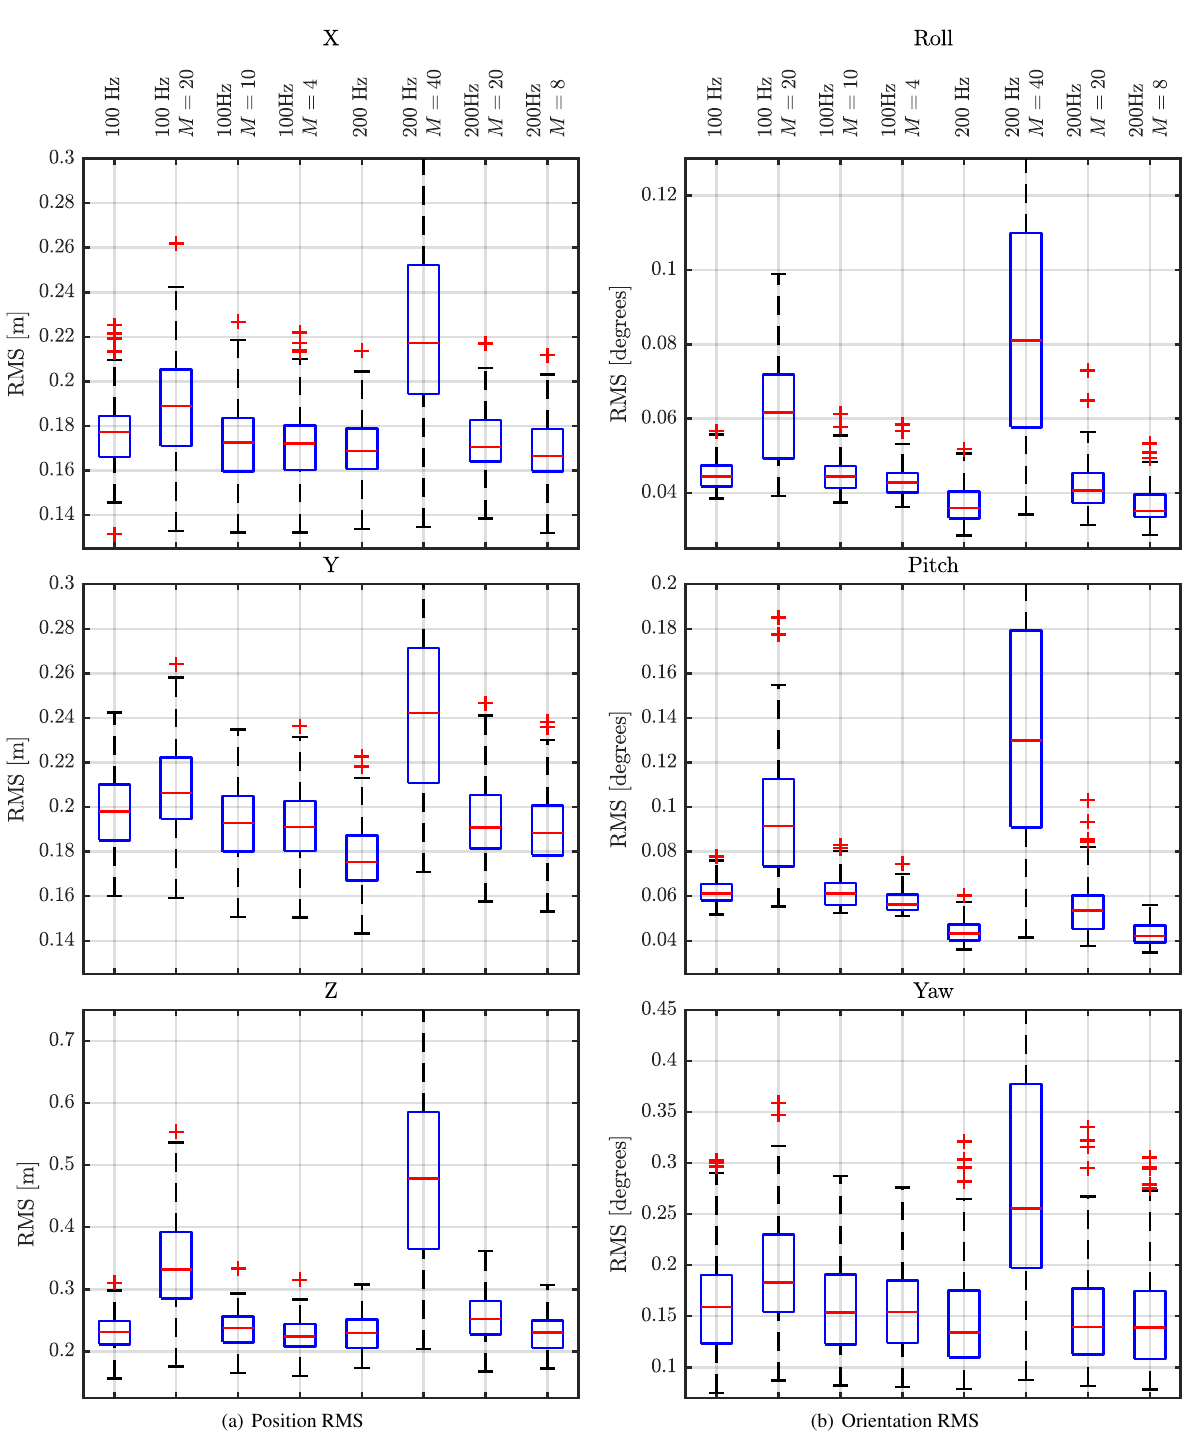
Figure 3. Box plot for the position and orientation RMS obtained in each Monte Carlo run, for each processing